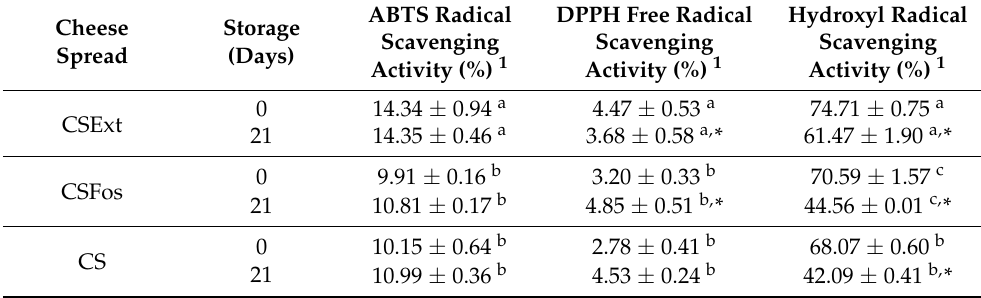
Table 2. Antioxidant capacities of the cheese spread incorporating Osmundea pinnatifida extract (CSExt), the cheese spread with fructooligosaccharides (CSFos), and the plain cheese spread (CS).